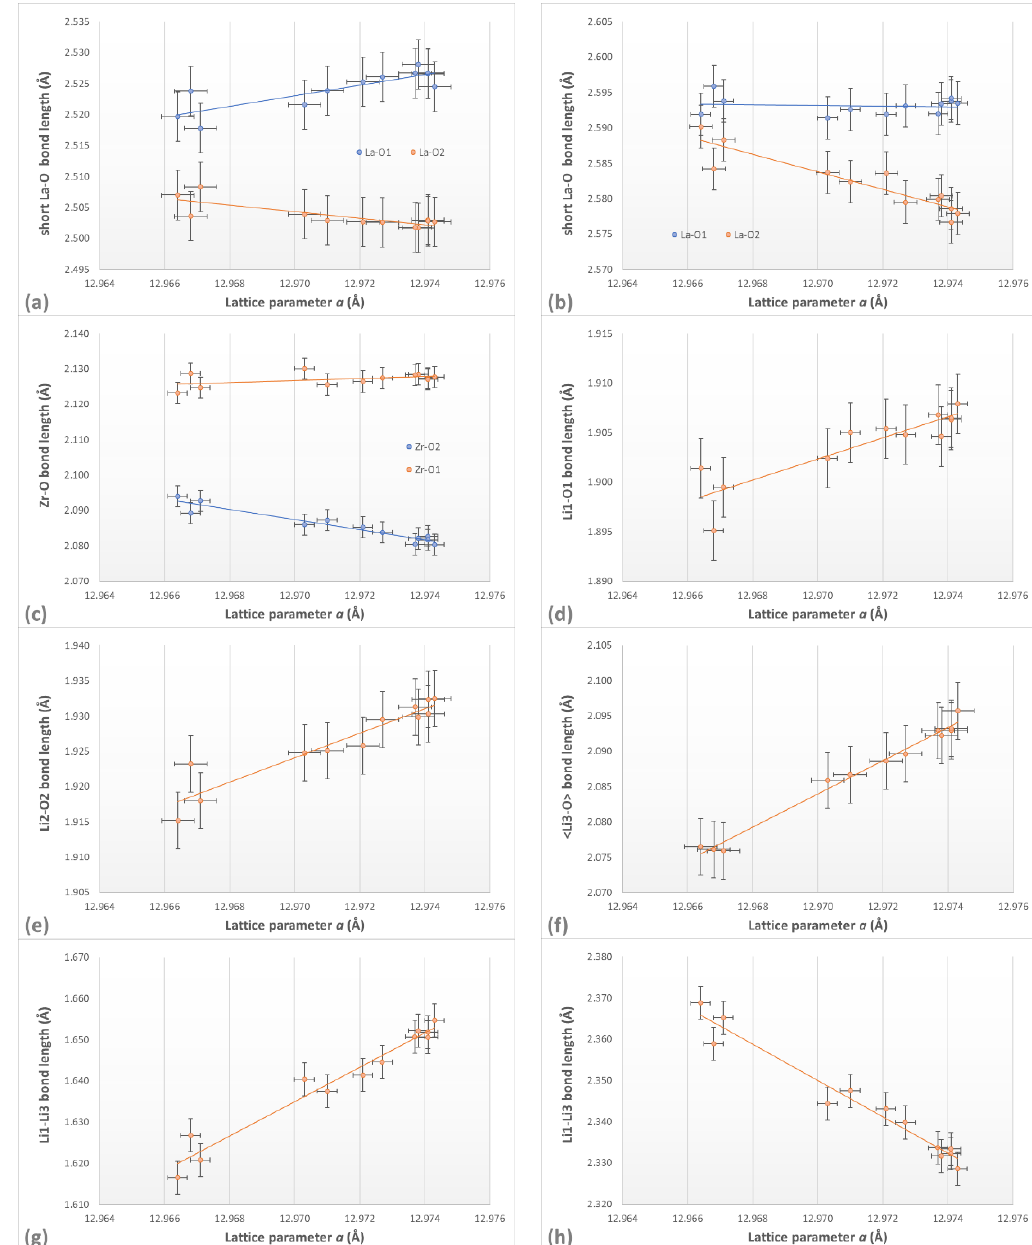
Figure A1. Variation of bond lengths in Ga10-LLZO with the unit cell parameters due to ongoing aging (Li + /H + exchange), data extracted from refinements of high-resolution single-crystal X-ray diffraction data: ( a ) Variation of the two short La – O bond lengths, ( b ) variation of the two long La – O bond lengths, ( c ) variations of the two different Zr – O bond lengths, ( d ) variations of the Li1 – O1 bond lengths, ( e ) variations of the Li2 – O2 bond lengths, ( f ) variations of the average Li3 – O bond lengths, based on the 4 shortest bonds, ( g ) variation of the interatomic separation of Li1 – Li3 sites and ( h ) variation of the interatomic separation of Li2 – Li3 sites with lattice parameter a .